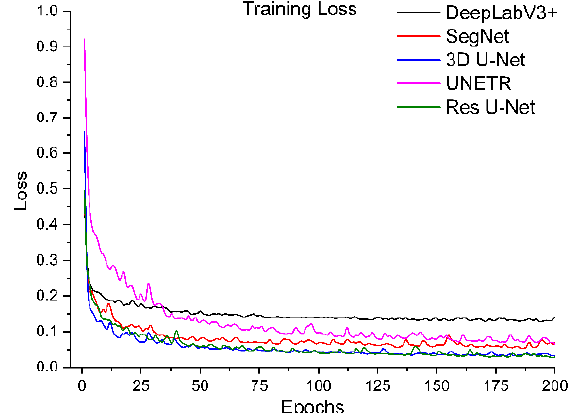
Figure 6. Training loss of segmentation networks trained with the proposed training scheme.